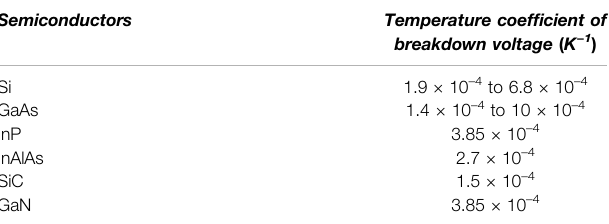
TABLE 2 | A summary of temperature coef fi cient of breakdown voltage of various semiconductors (Hall, 1967; Vassilevski et al., 2000; Groves et al., 2003; Tan et al., 2010; Ji et al., 2020b).